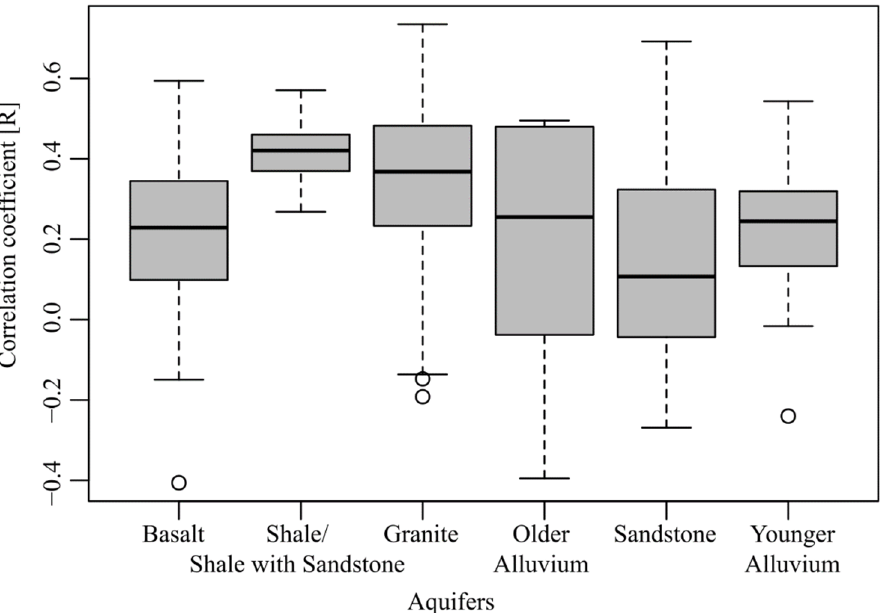
Figure 7. The box plot of correlation coefficient ( R ) between groundwater fluctuation and monsoon rainfall (JJAS) of aquifers systems in the Betwa River basin. The extended dashed lines represent the minimum and maximum R ‐ value ranges. The horizontal line in the box (solid black) represents the median value.